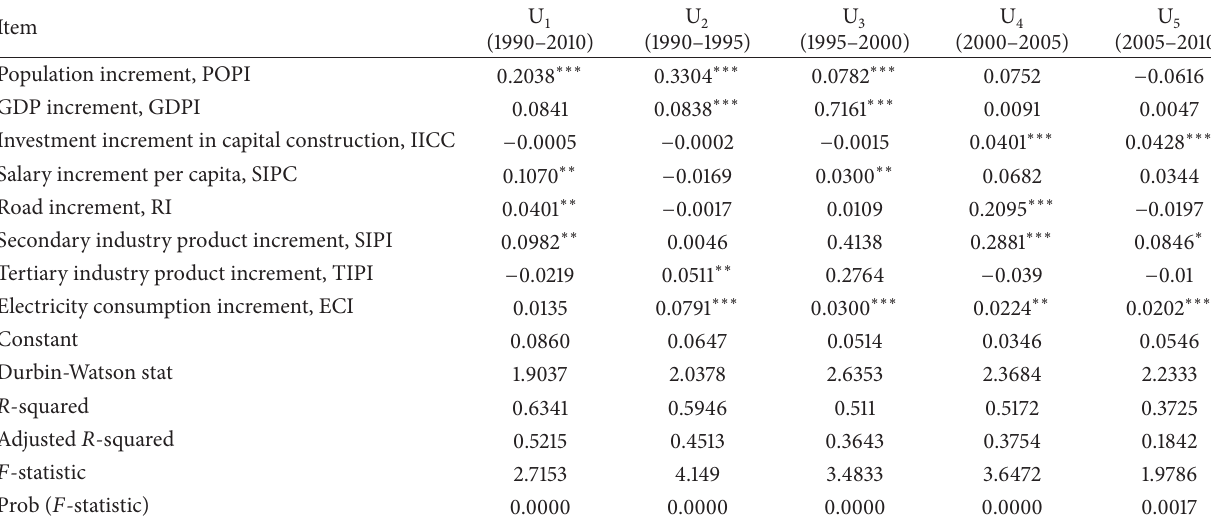
Table 3: Urban expansion and driving factors in 1990–2010 in China.